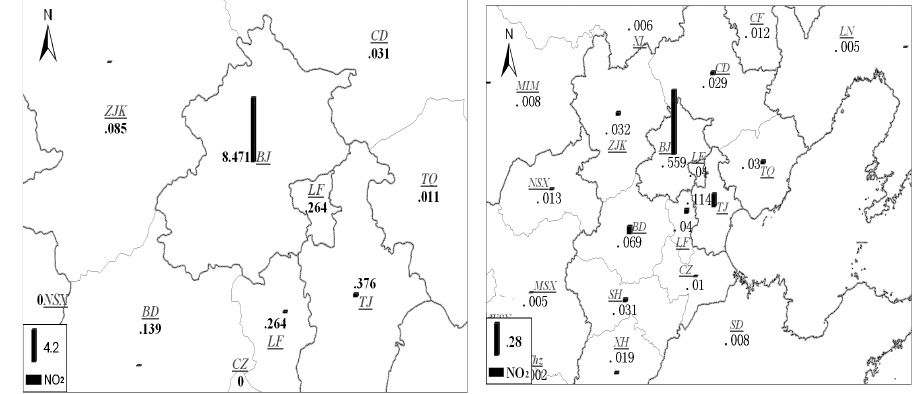
Fig. 11. Same as Fig. 6, but for NO 2 .